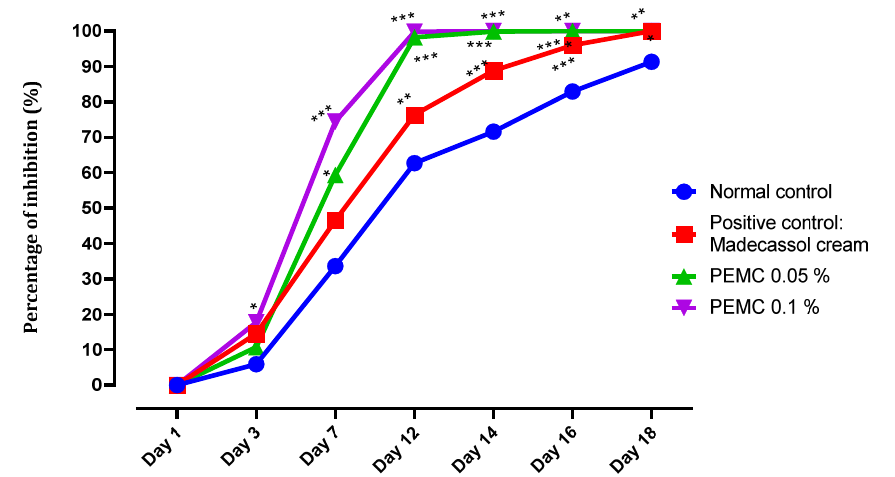
Figure 5. Wound healing assessment after treatment with PEMC containing ointments. The results are expressed as mean ± standard deviation. The tests were done in quintuplicates; * p < 0.05; ** p < 0.01; *** p < 0.001 compared to the normal